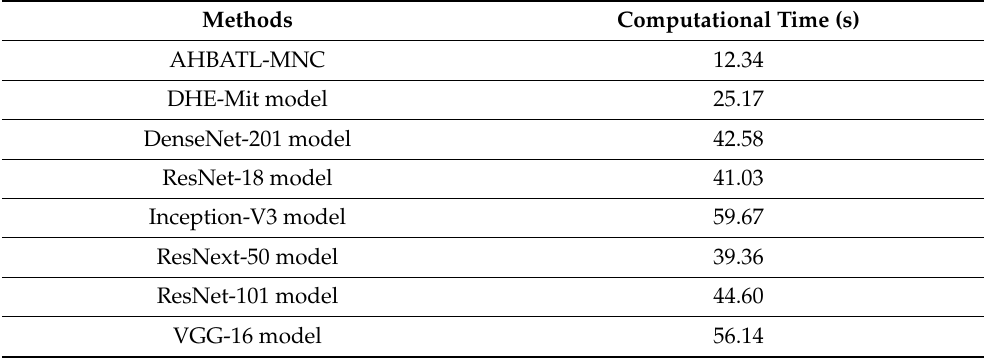
Table 5. Comparative CT analysis of AHBATL-MNC system with other